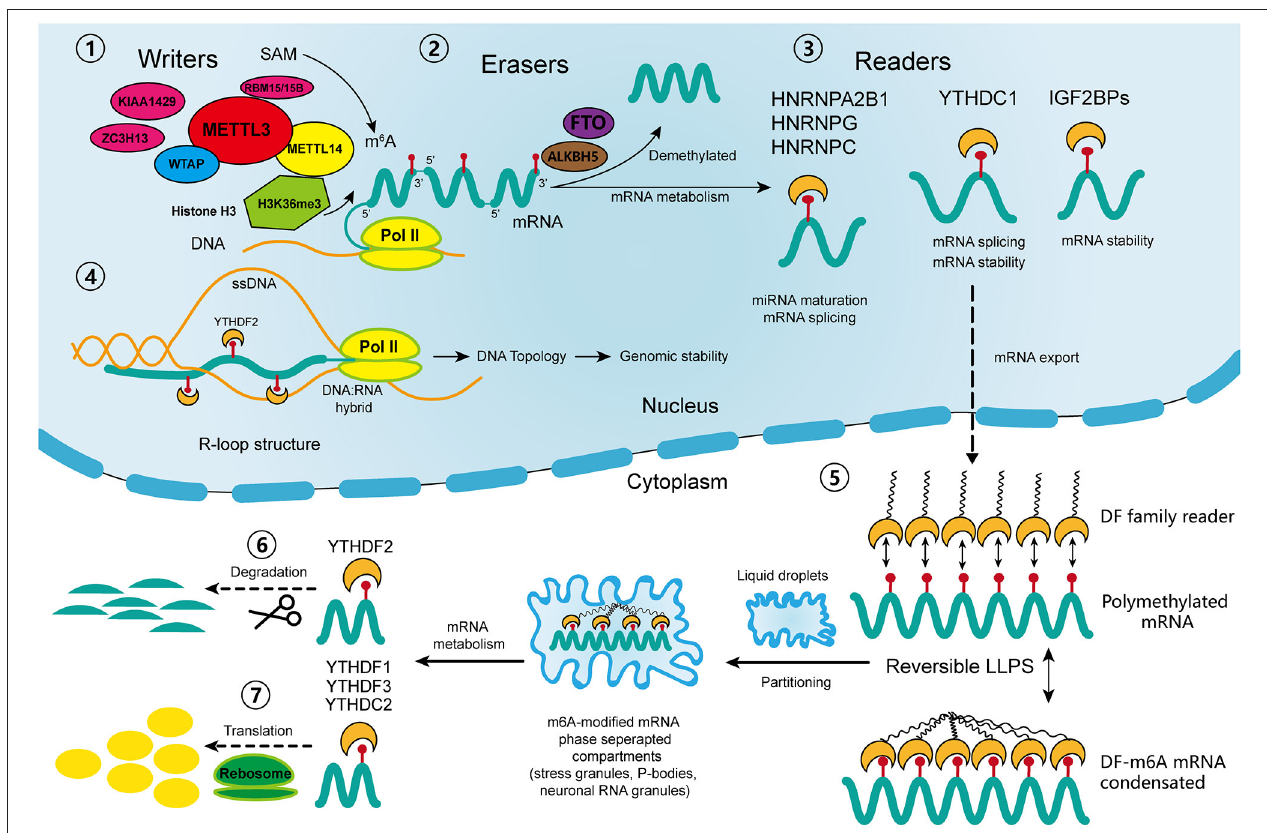
FIGURE 1 | Schematic diagram of the process and biological function of RNA m 6 A methylation. The methyltransferase complex composed of METTL3, METTL14 and WTAP co-transcriptionally catalyzes the transfer of the methyl group from adenosylmethionine (SAM) onto the N6 position of adenosine; other “writers” include RBM15/15B, KIAA1429, and ZC3H13. With the guidance of histone H3K36me, the m6A sites are preferentially located near the 3 ′ terminus of the transcripts. Demethylases FTO and ALKBH5 reverse the m 6 A process. In nucleus, the “readers” of YTHDC1, IGF2BPs, HNRNPs participate in diverse RNA biological processes, including mRNA alternative splicing, stability, export, and miRNA maturation. The m 6 A-modified R-loop structures are implicated in the regulation of genomic stability. In cytoplasm, the m6A-modified mRNAs are targeted for regulation through a process called liquid-liquid phase separation (LLPS), which is mediated by YTHDFs. Then, other “readers” regulate the degradation and translation of mRNAs in the cytoplasm. ssDNA, single strand DNA; pol II: RNA polymerase